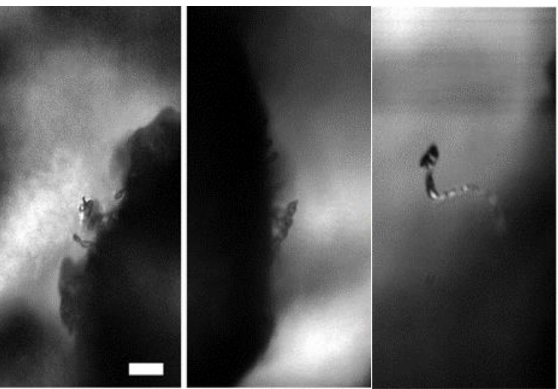
Figure 7. Examples of the shorter methane hydrate filaments growing from sand grains at 7 MPa, 2 ◦ C in run 6. Scale bar: 20 µ